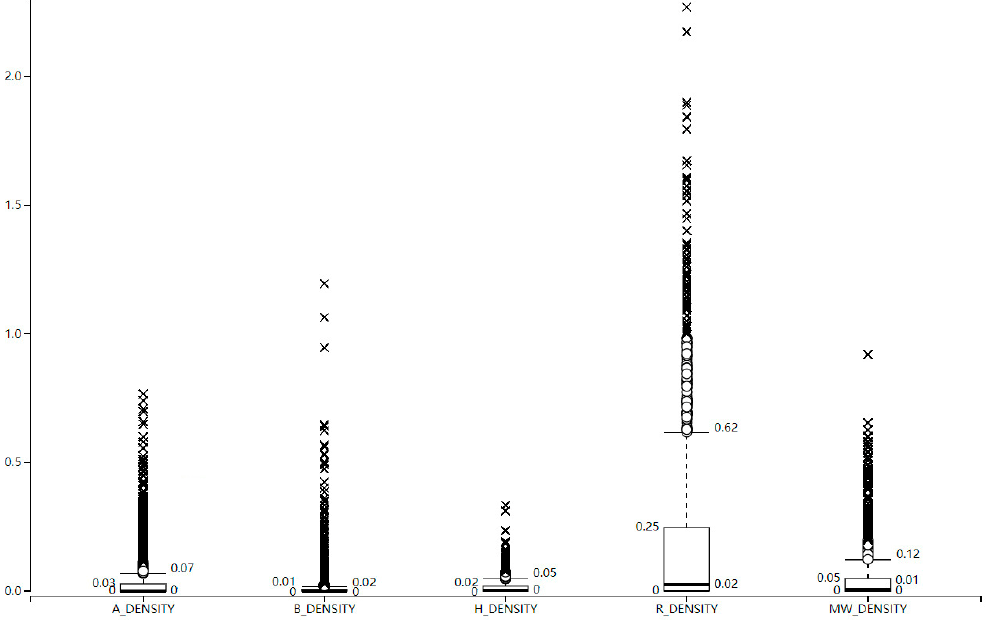
Figure 5. Box diagram of five types of building